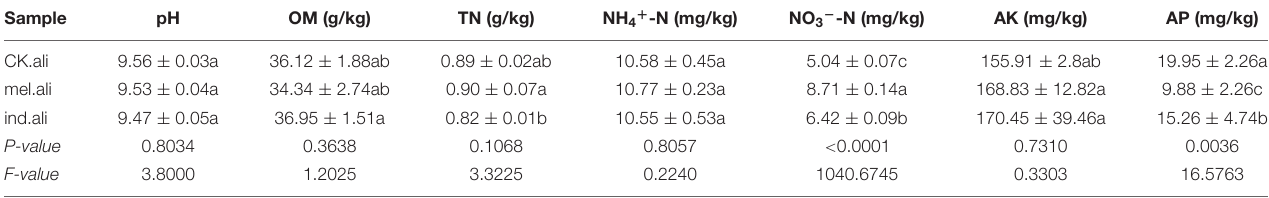
TABLE 2 | Physical and chemical properties of soil samples.